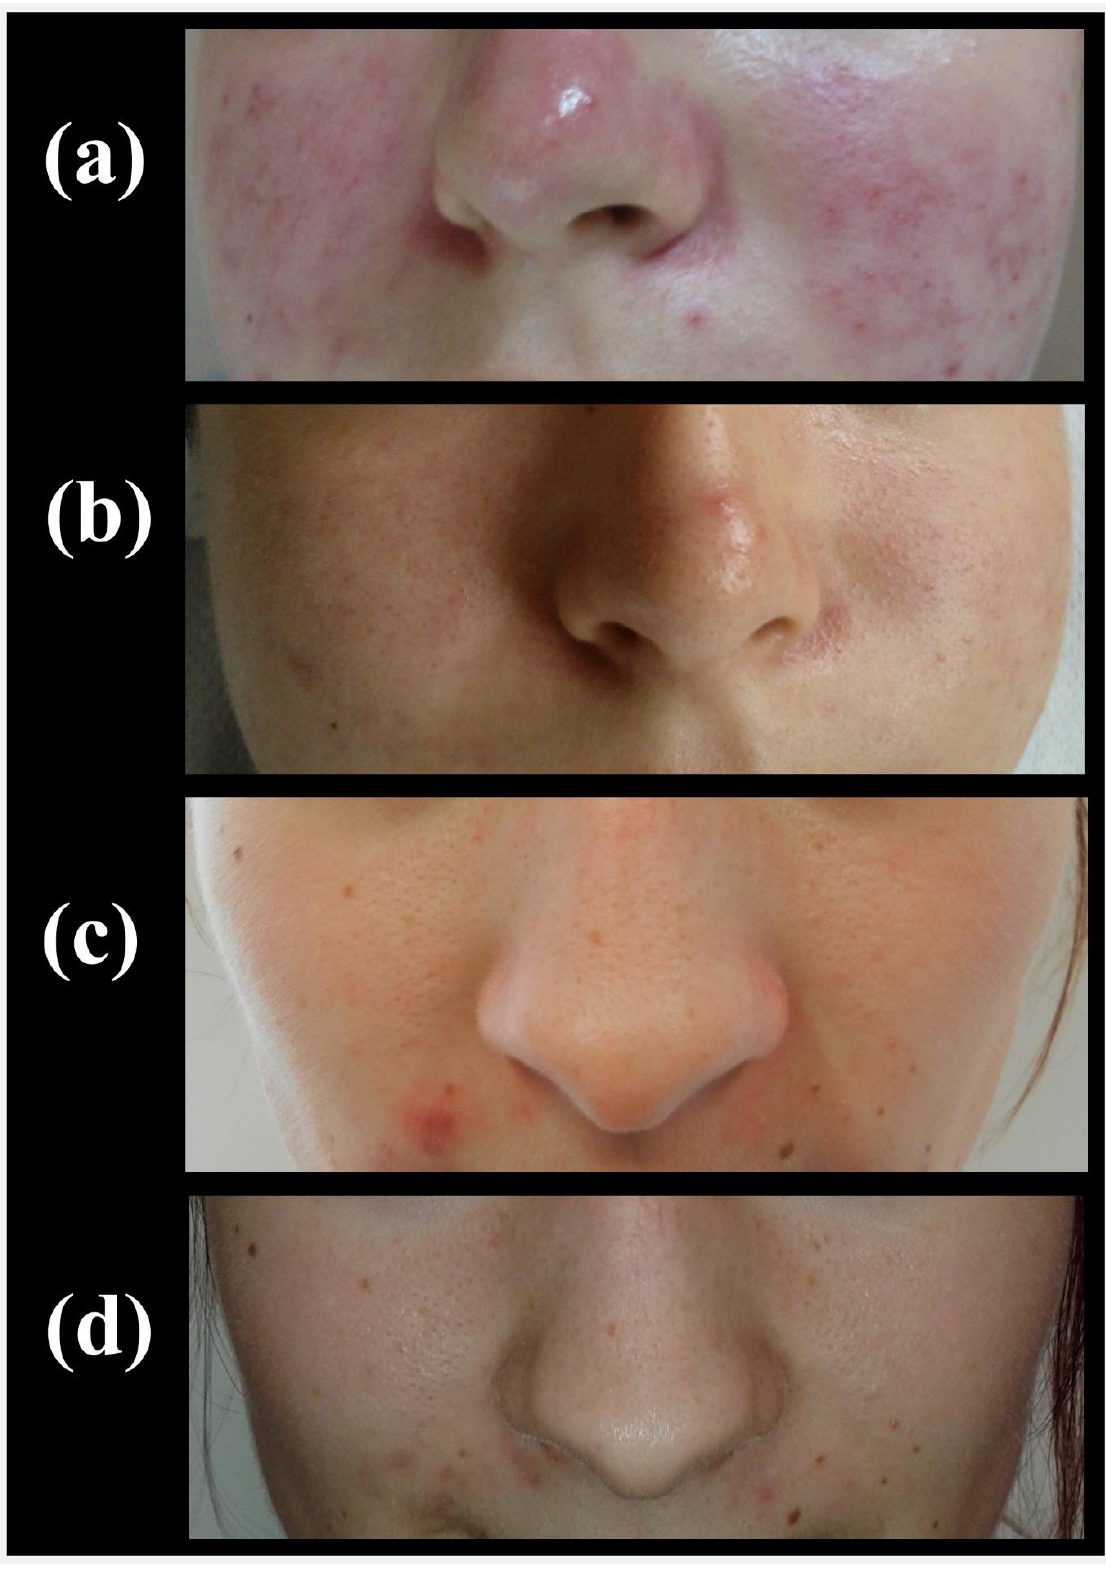
Figure 3. Acne severity in a participant from the experimental group: ( a ) before treatment, and ( b ) 2 weeks after treatment; and in a participant from the control group: ( c ) before treatment, and ( d ) 2 weeks after treatment.